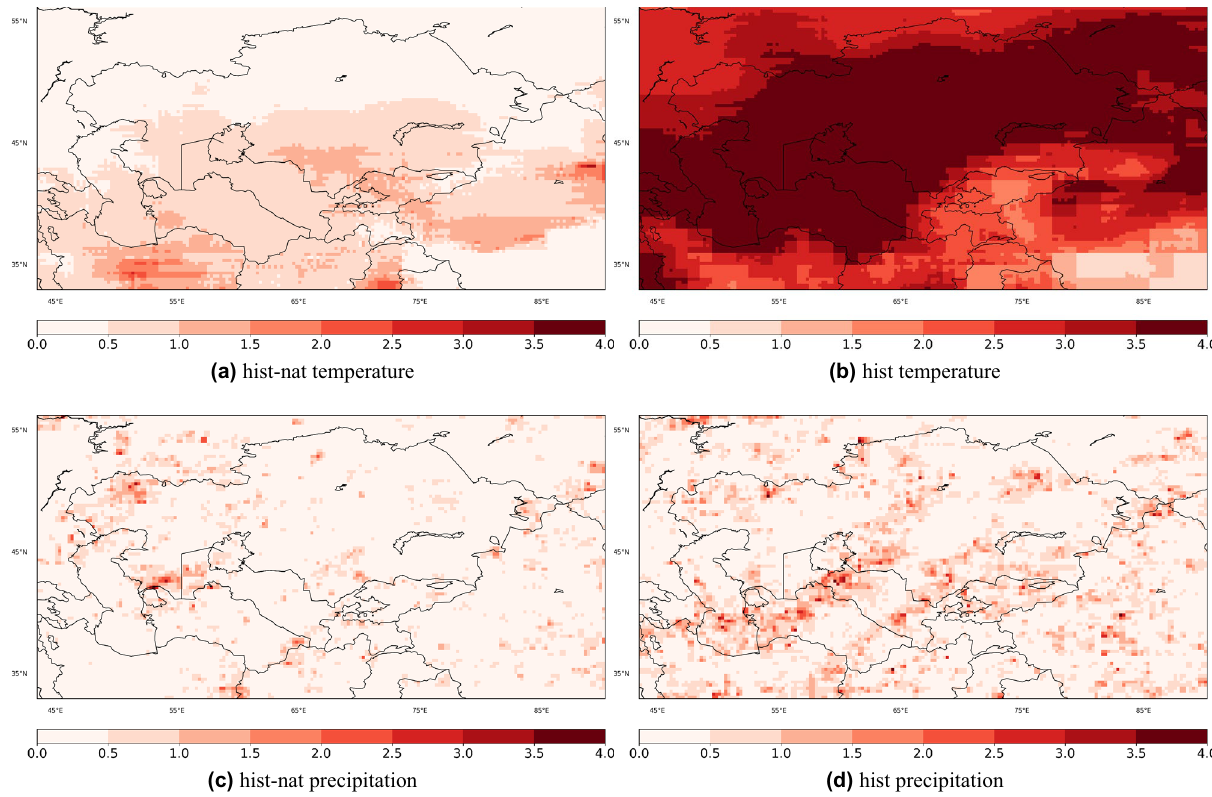
Figure 5. Signal-to-noise ratio maps for yearly temperature trends during 1979–2014 from hist-nat ( a ), hist ( b ), th as well as for the yearly precipitation’s 99.9 percentile from hist-nat ( c ), hist ( d ). The maps were created using python3-matplotlib (version 3.1.2, https:// matpl otlib.